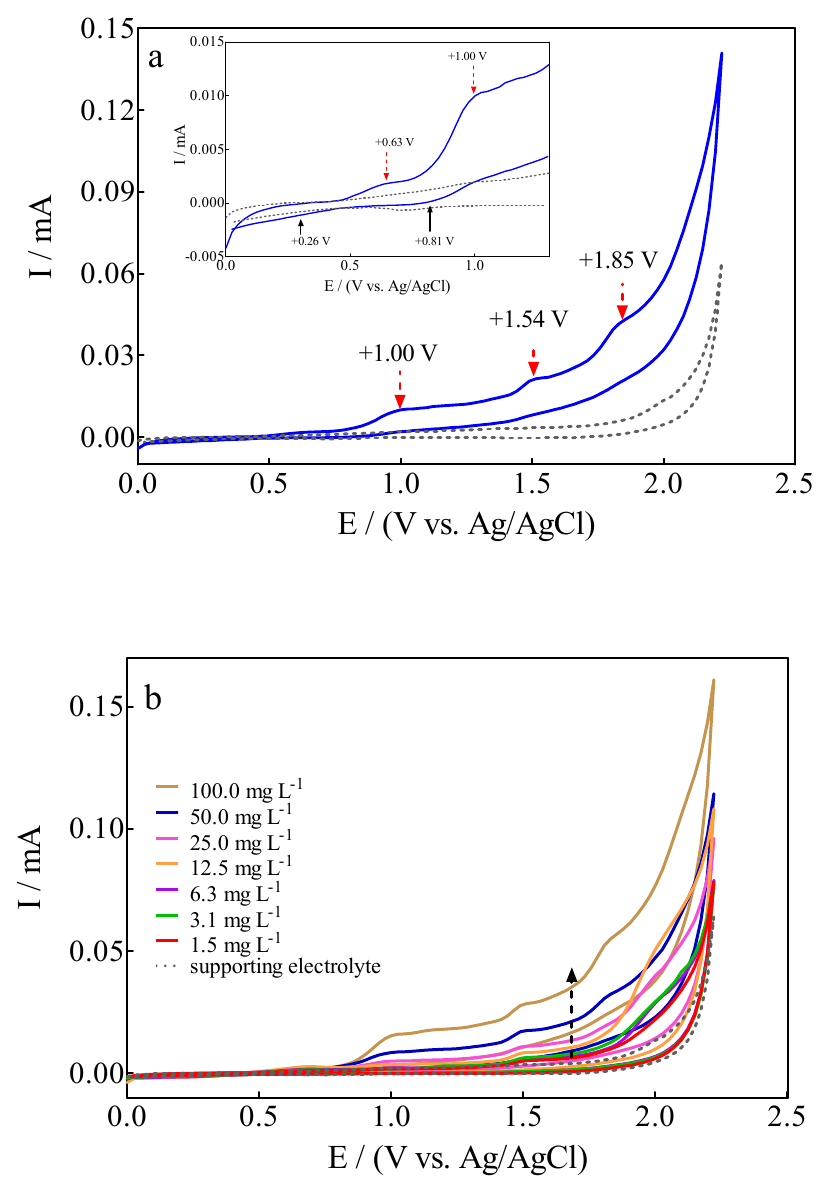
Figure 2. ( a ) Cyclic voltammograms for ( ▬ ) 100 mg L − 1 Calcon + 0.25 M H 2 SO 4 solution and ( --- ) supporting electrolyte on BDD electrode at 50 mVs − 1 in the potential range from 0.0 V to +2.3 V (vs Ag/AgCl (3M KCl)). ( b ) Electrochemical behavior of anodic and cathodic peaks at the CV profiles, as a function of Calcon dye concentration (1.5–100 mg L − 1 ), at 25 °C. The four observed anodic peaks were located at +0.63 V (E pa 1), +1.00 V (E pa 2), +1.54 V (E pa 3) and +1.85 V (E pa 4), while only two cathodic peaks were detected at +0.26 V (E pc 1) 100 mV s −1 (Figure 3). dye at its surface [43]. Anodic peaks (E pa 1 = +0.63 V and E pa 2 = +1.00 V) at the lower overpotential region (<1.6 V) are associated with direct electron-transfer on the diamond surface, while the current-voltammetric signals (E pa 3 = +1.54 V and E pa 4 = +1.85 V) at the high overpotential region (>1.62 V) should be related to the indirect oxidation